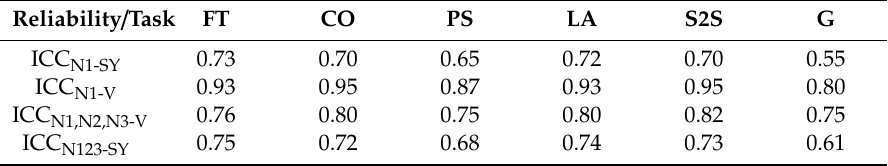
Table 1. Intra class correlation coe ffi cients a for system reliability and raters’